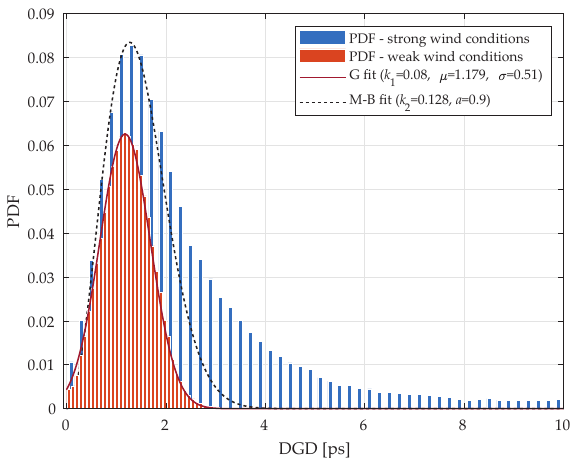
Figure 7. Probability density functions versus DGD retrieved from experimental measurements. The probability density functions are then fitted with different models: Gaussian model for weak wind conditions and Maxwell–Boltzmann model for strong wind conditions.